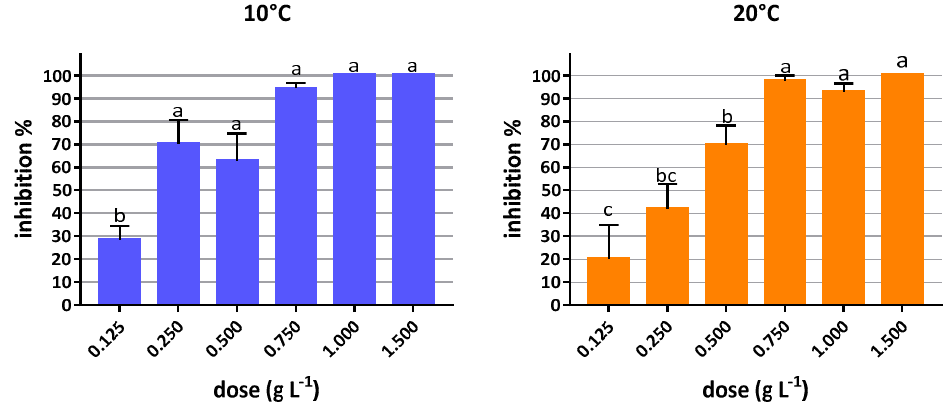
Figure 6. Percent inhibition of F. circinatum conidia germination at two different temperatures (10 ◦ C and 20 ◦ C) with the dose of BioFence ® 0.125, 0.25, 0.5, 0.75, 1, and 1.5 g L − 1 . No significant differences were found between the isolates FcCa1 and Fc015; thus, data were combined for the statistical analysis. Different letters indicate significant differences at p < 0.05, according to Tukey’s post-hoc test. Vertical bars = SE.